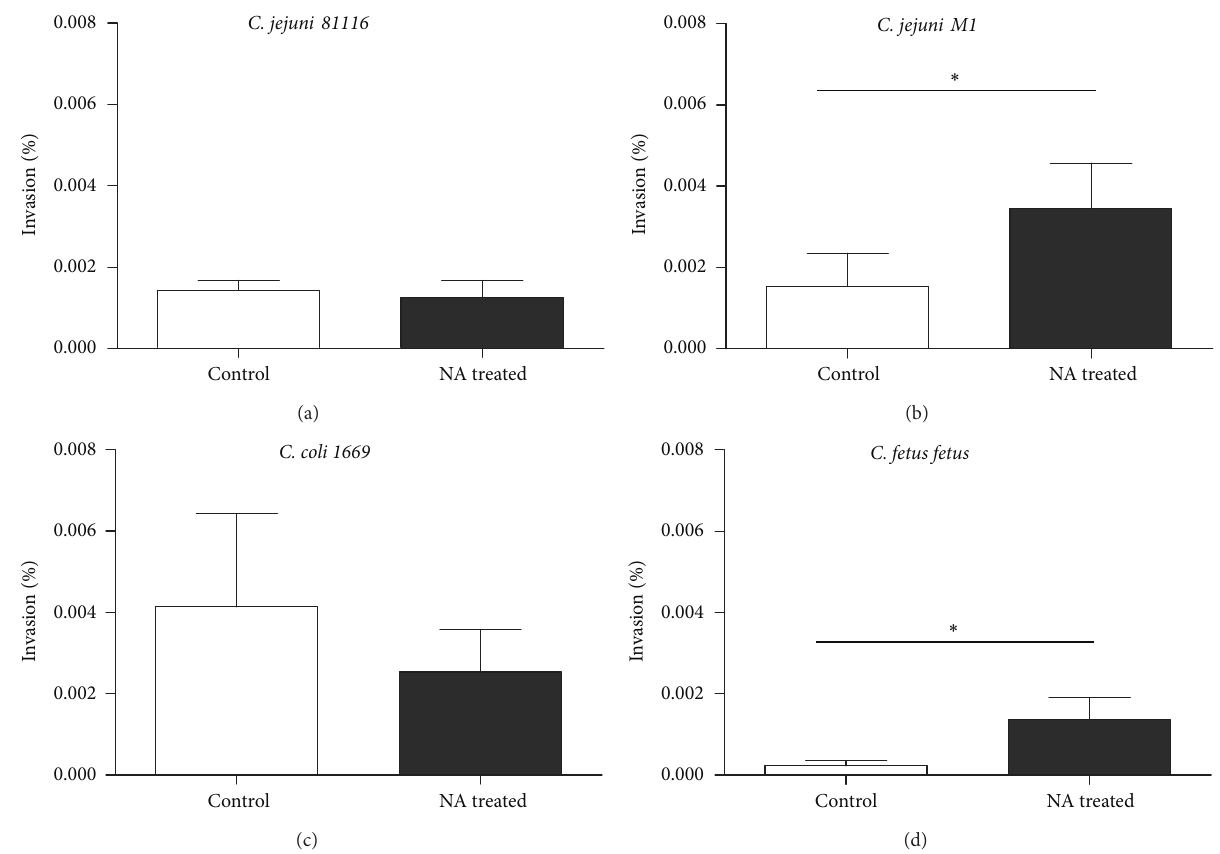
Figure 3: Invasion of T84 epithelial cells by C. jejuni 81116 (a), C. jejuni M1 (b), C. coli 1669 (c), and C. fetus fetus (d) at 37 ∘ C was determined by gentamicin protection assay. The percentage of invading cells in the inoculum in the presence (black) or absence (white) of noradrenaline is shown. Results are the mean of three separate experiments, and bars represent standard error. Star indicates 𝑃 < 0.05